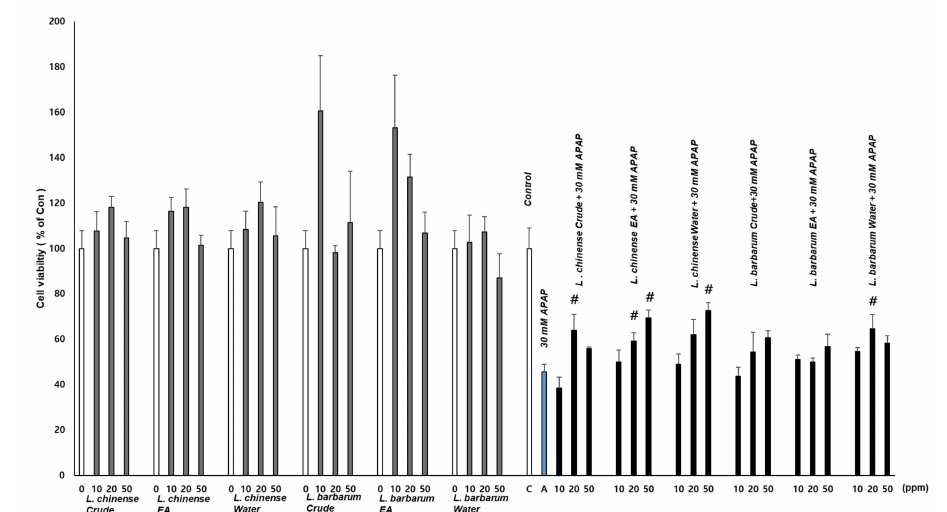
Figure 1. E ff ects of the L. chinense and L. barbarum crude extracts and fractions on HepG2 cell viability. The extracts were treated for 24 h with or without 30 mM acetaminophen and the resulting cell viability was measured via the WST-1 assay. n = 4 or more; # indicates a significant di ff erence from the acetaminophen (APAP)-only group ( t -test, p <